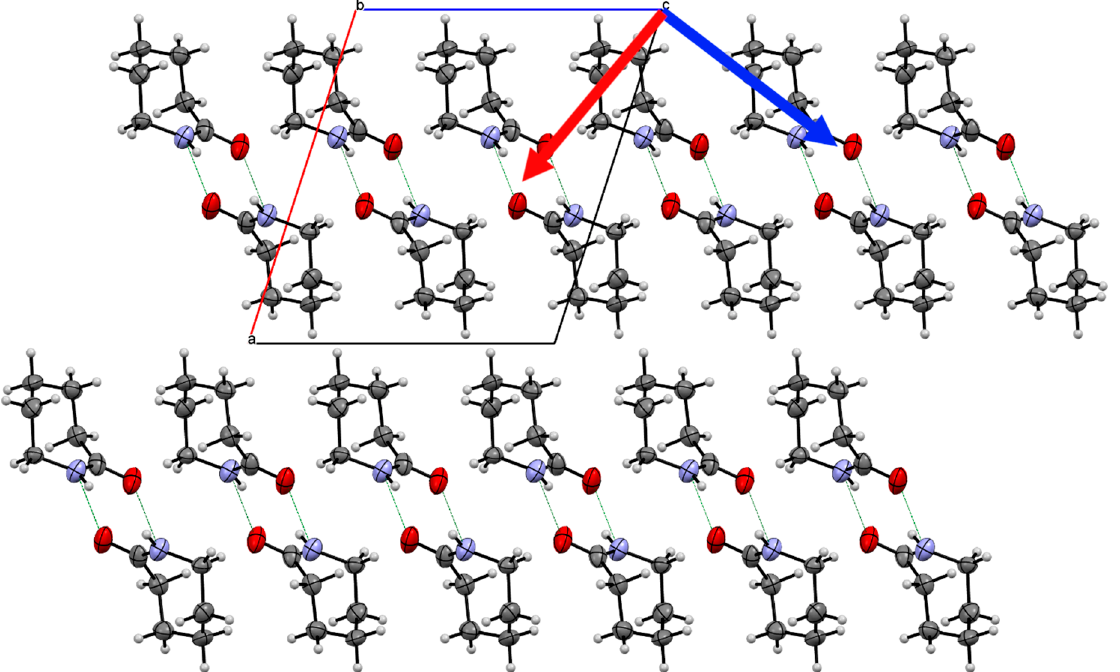
Figure 5. Crystal structure of Form II caprolactam viewed down the b -axis indicating two of the principal components of strain (Red arrow 19.1(2) TPa − 1 ; Blue arrow 4.58(11) TPa − 1 ). The third component is along the b -axis. The blue arrow indicates the direction of least compression. Whilst the molecules of one chain are positioned between the molecules of the neighbouring chain, the orientation of the molecules does not allow an increase in the degree of interlock.